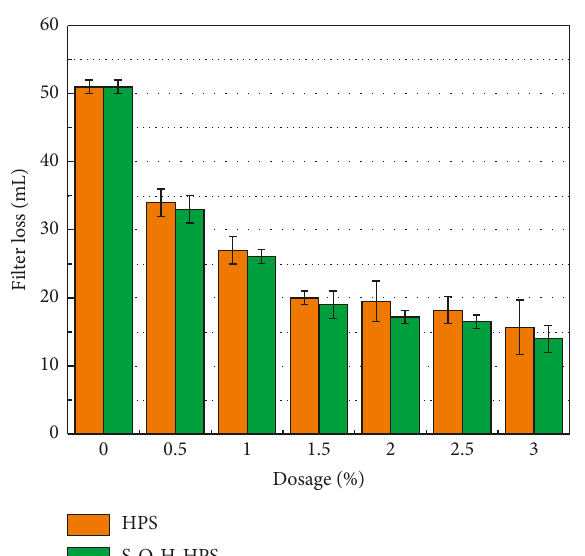
Figure 4: Variation of cement slurry filtration with HPS and S-O- H-HPS additions.